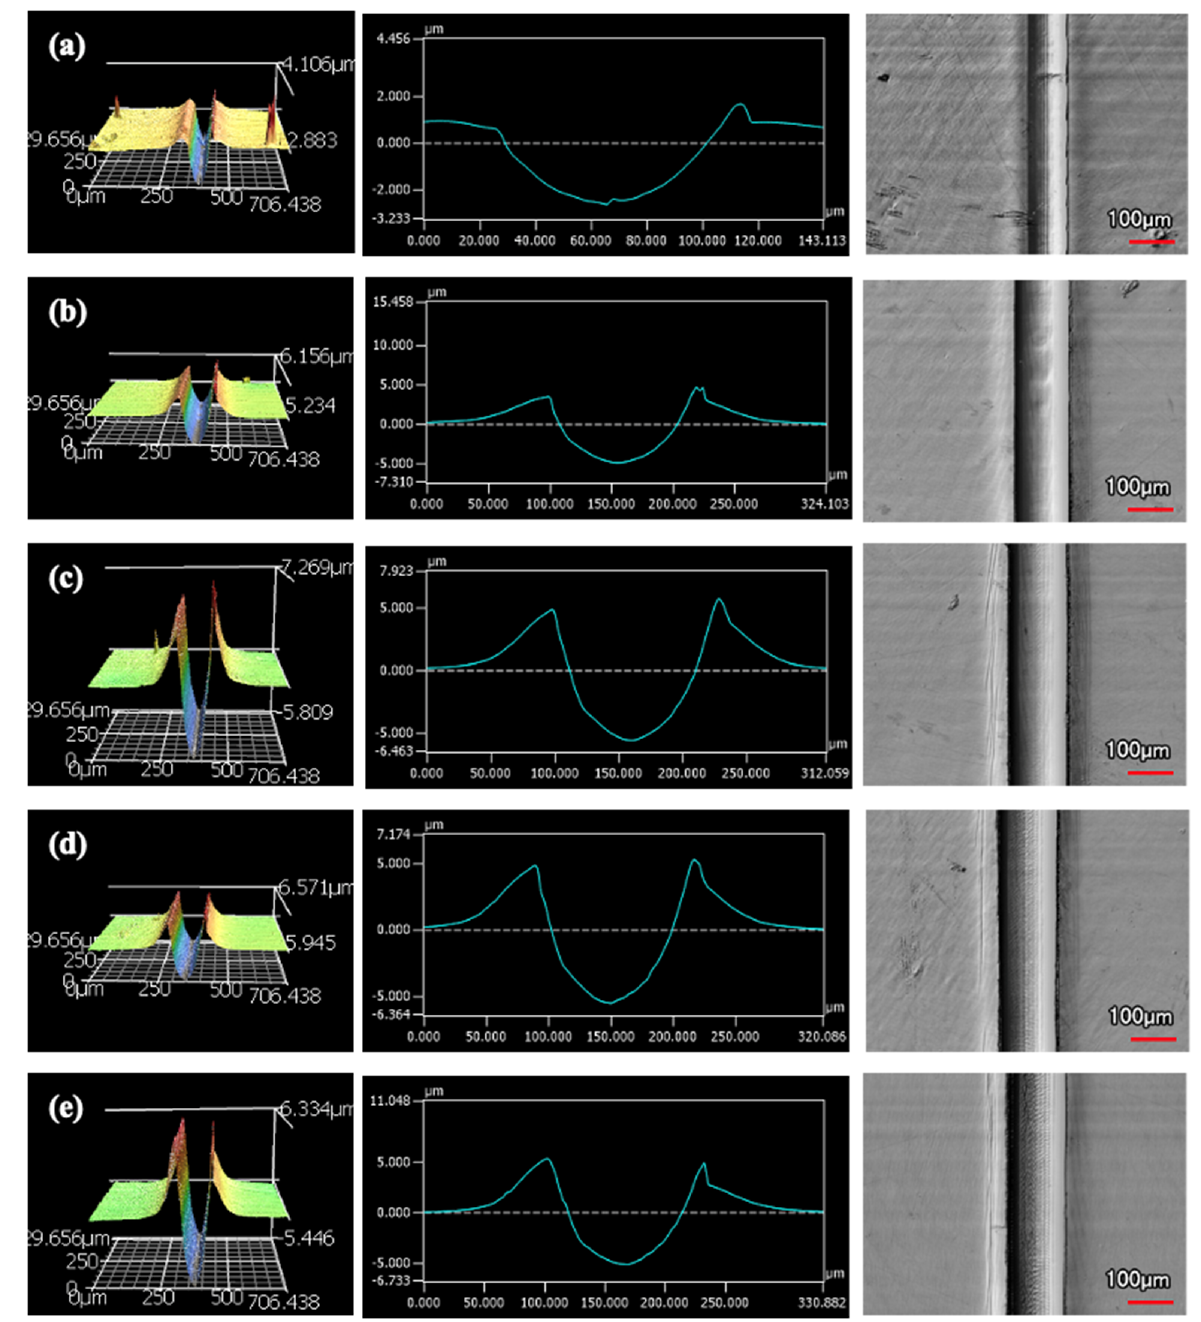
Figure 10. Wear Profiles from the Sharp Indenter on 9 μ m Thick Ni − P Coating: ( a ) 1 Pass, ( b ) 25 Passes, ( c ) 50 Passes, ( d ) 75 Passes, ( e ) 100 Passes.